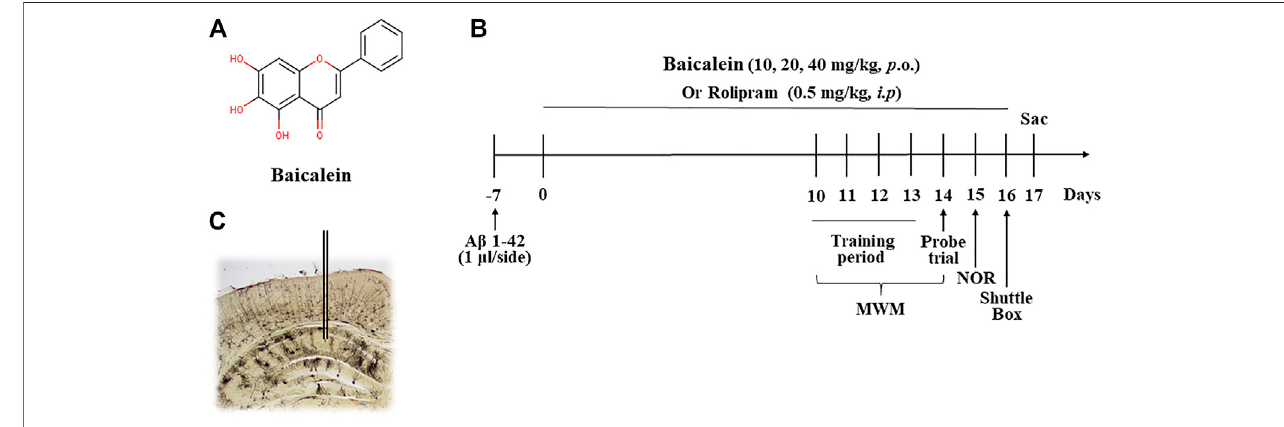
FIGURE 1 | The chemical structure of baicalein (A) , treatment timeline and test order for mice treated with different doses of baicalein (B) , and (C) photomicrographs of representative cannula placements in the CA1 of hippocampus for treatment of A β oligomers were shown. MWM, Morris water maze; NOR, novel object recognition; Sac, sacri fi